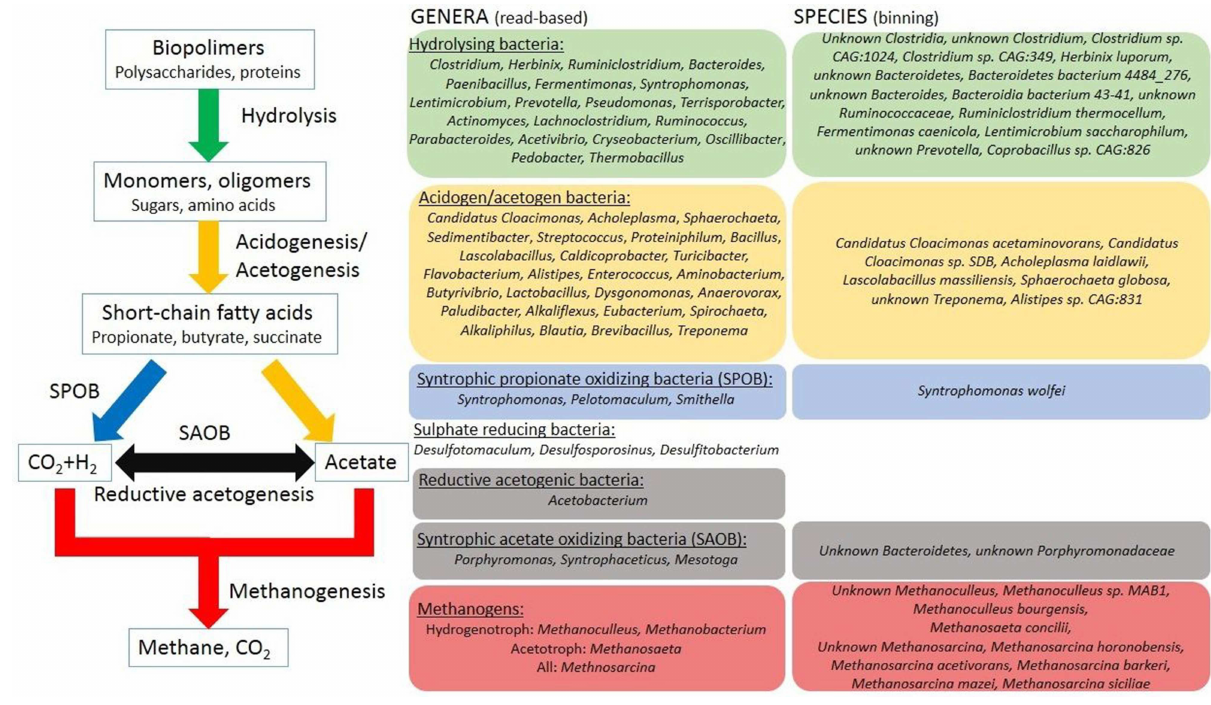
FIGURE 5 | The distribution of the core microbial genera along the biogas producing microbial chain of events. The identified core microbes are arranged according to their known physiological roles in the steps of the anaerobic degradation process. Binning results are applied to make more detailed food chain. For detailed explanation see text. SAOB, syntrophic acetate oxidizing bacteria; SPOB, syntrophic propionate oxidizing bacteria. The genera are listed as their mean abundance order in the boxes.